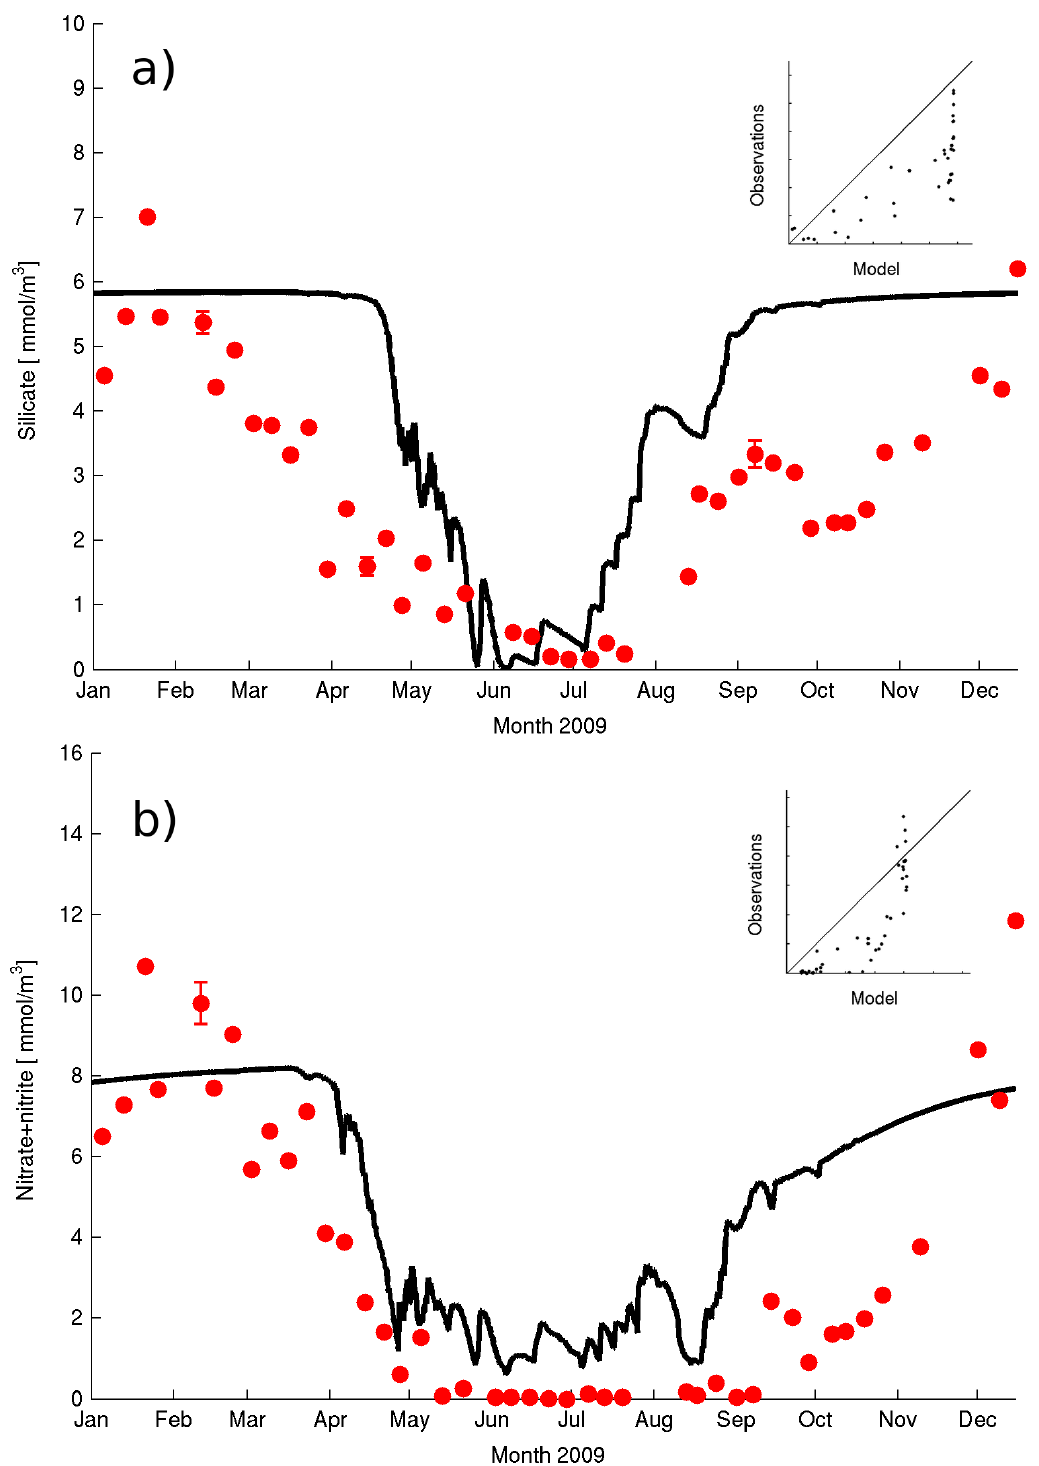
Figure 6. Evolution at the surface of ( a ) dissolved silicate and ( b ) dissolved nitrate concentration during 2009. The observations correspond to the red dots while the model is the solid line. The errors associated with the observations are included as error bars. In most cases, the errors are very small, and the error bars are smaller than the marker and are not visible. The one to one plot between observations and model results is included as a thumbnail to illustrate the correspondence between the